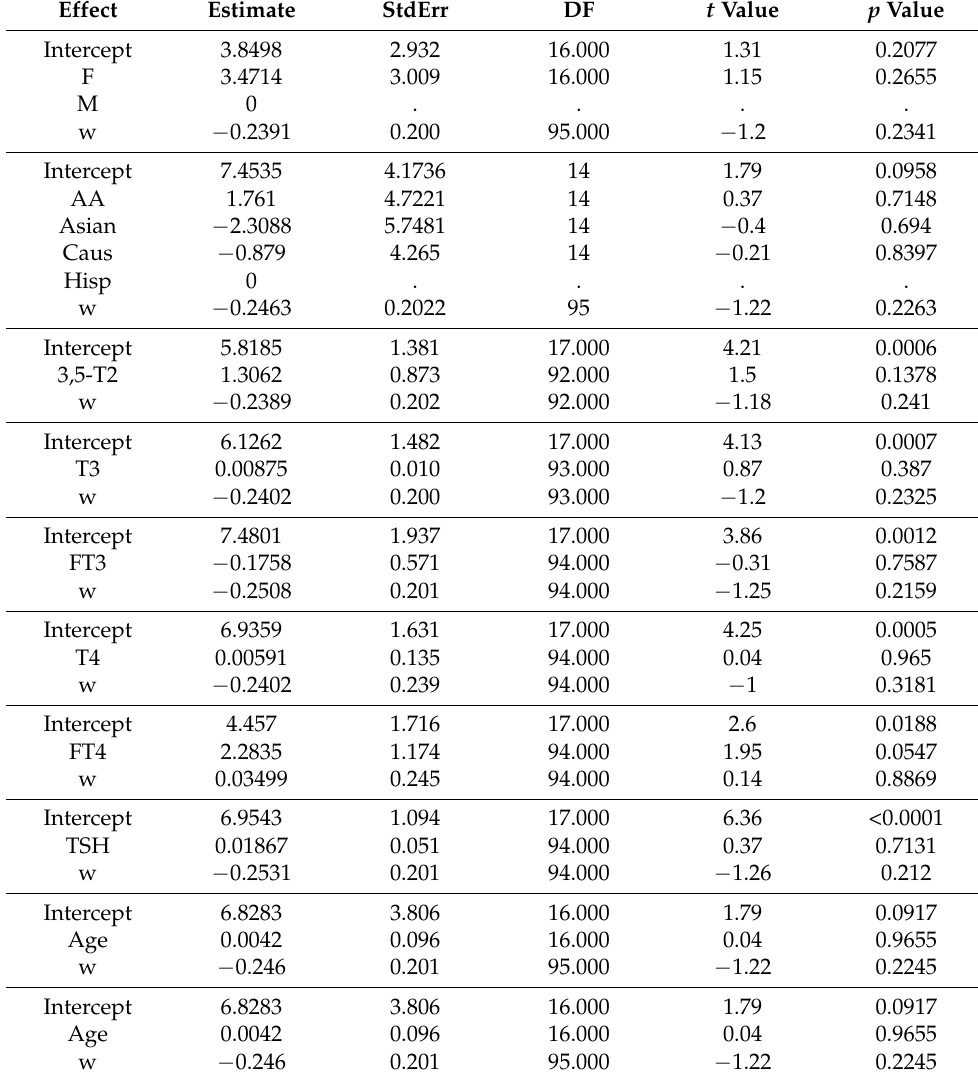
Table A4. Analysis of 3-T1AM levels: Participants with hypothyroidism,